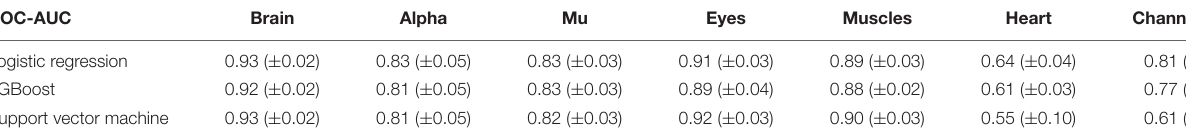
TABLE 3 | Average ROC-AUC values and their standard deviations. ROC-AUC Brain Alpha Mu Eyes Muscles Heart Channel noise Logistic regression